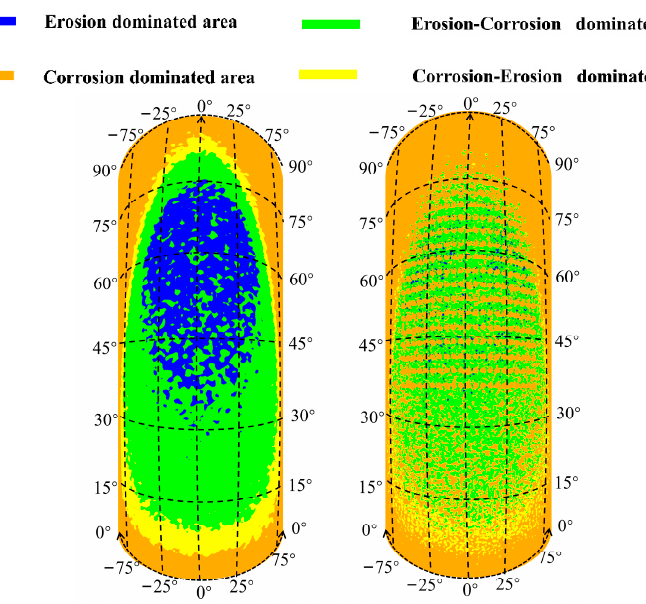
Figure 24. Erosion–corrosion map for the outer wall.